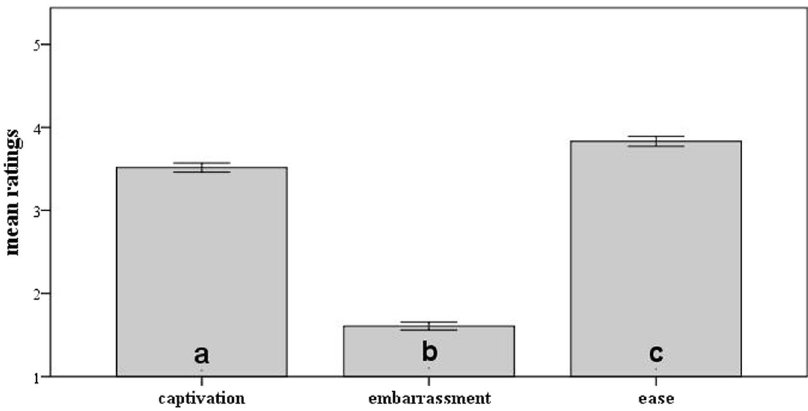
Fig. 5 Mean ratings for each of the three components re fl ecting the feelings participants associate with reading erotic novels. Error bars indicate the standard error of the mean. Means with different letters are signi fi cantly